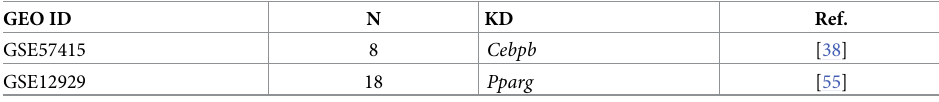
Table 4. Perturbed MDI-induced 3T3-L1 gene expression data by